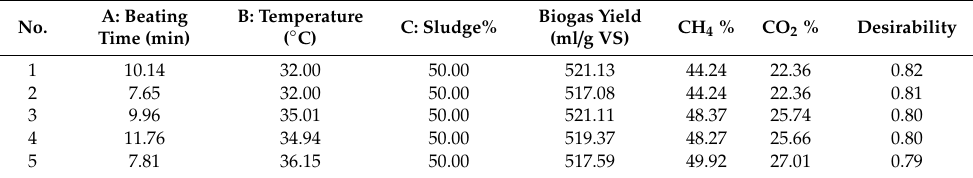
Table 21. Numerical optimisation solutions for AD of pot ale.